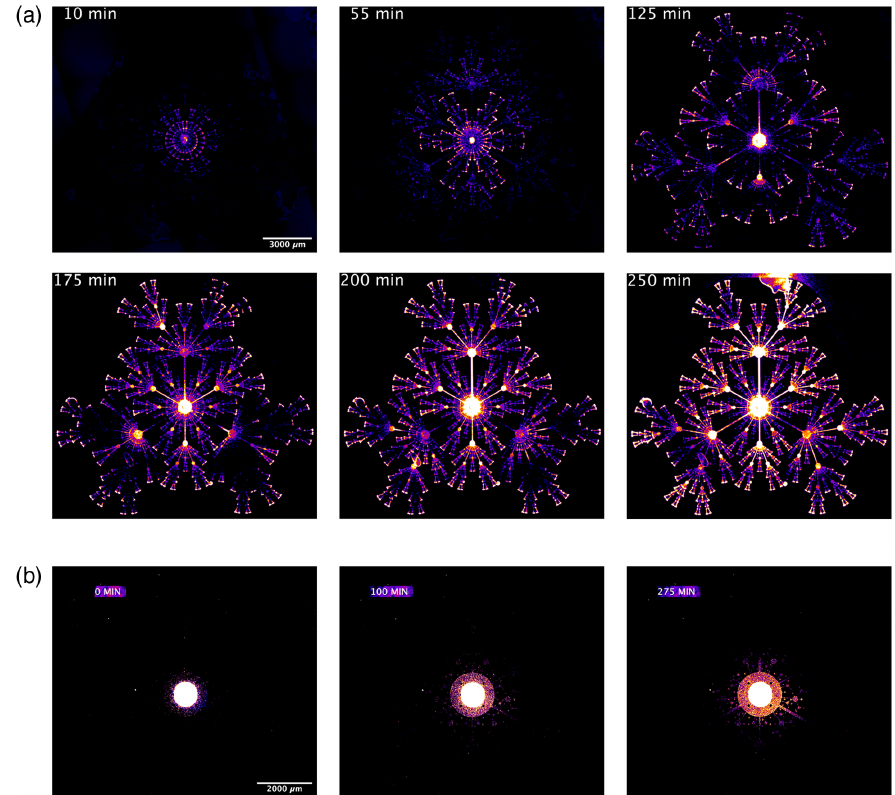
FIG. 5. (a) Sequence of stitched images of chemosensitive bacteria after inoculation in a fractal at the indicated times. (b) Nonchemosensitive bacteria slowly diffuse into the fractal and show no pumping or collective